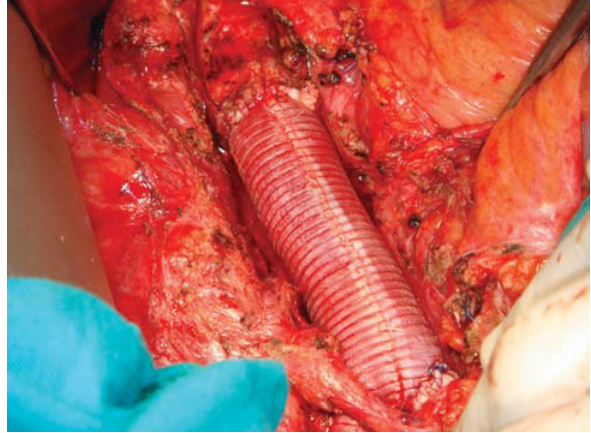
Fig. 4 - In situ aortobifemoral reconstruction with the constructed bifurcated corrugated bovine pericardial tubular graft